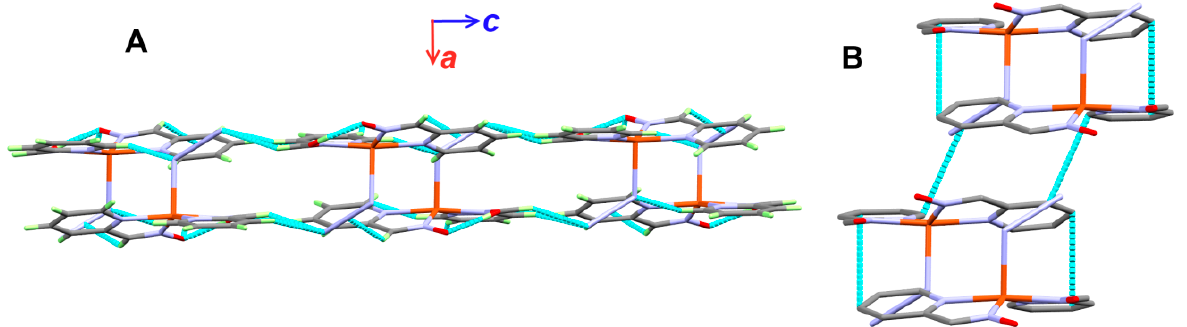
Figure 6. Hydrogen bridge contacts ( A ) and packing view along a-axis ( B ) in 2 .